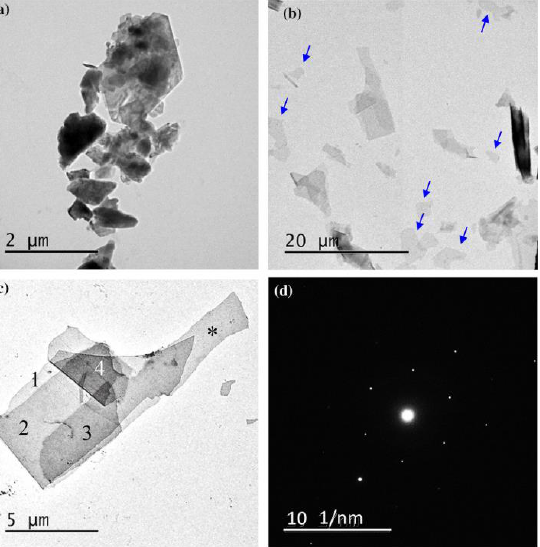
Figure 24. The effect of sonication integrated with PLAL. Carbon nanostructures ( a ) without soni- cation, ( b ) with sonication, ( c ) zoom of b, ( d ) electron diffraction pattern of a single-layer graphene indicated by an asterisk in ( c ) [55].